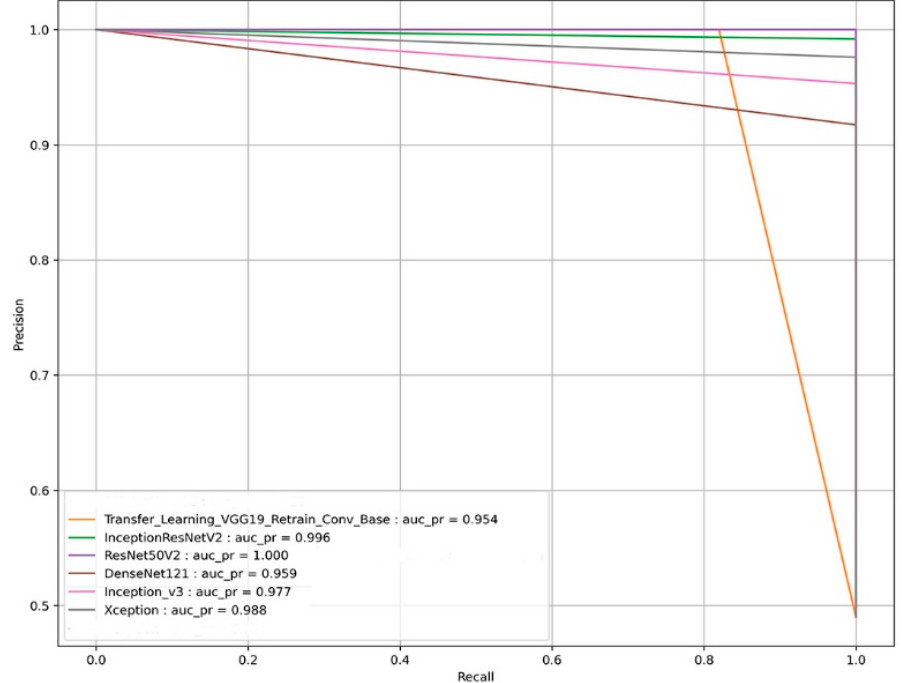
Figure 12. The AUC_PR curve-based performance comparison of the six state-of-the-art transfer learning models for the image-based classification of the fibrosis and normal classes from the testing CT scan image